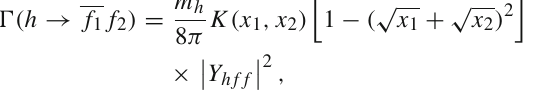
Table 7 Couplings of CP-odd neutral Higgs bosons, where p a , p + and p 0 are respective incoming momenta of h a , h + and h 0 1